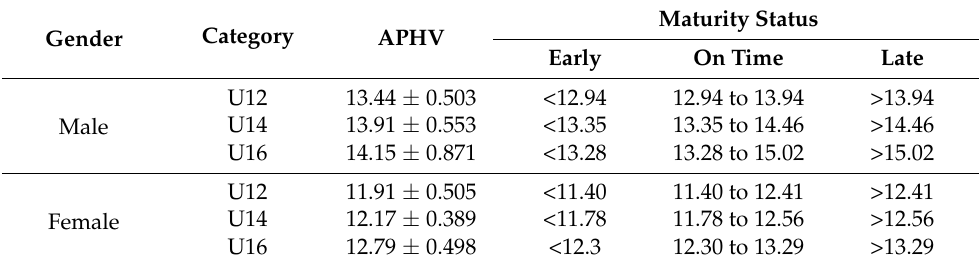
Table 1. Classification of the maturity status according to the PHV of each age group.